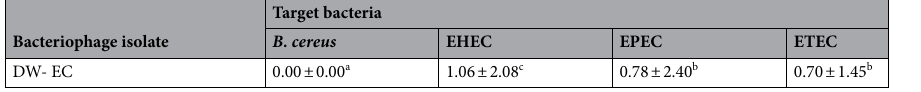
Table 1. Host spectrum and efficiency of plating (EOP) of bacteriophage DW-EC. Different letters indicate significant different between DW-EC treatment to against several biofilm pathogenic bacteria with P ≤